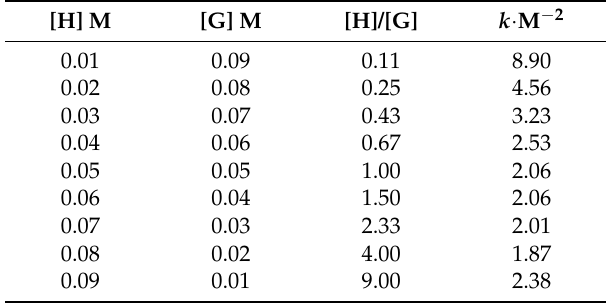
Table A1. Binding constant ( k ) calculated for every concentration used in the